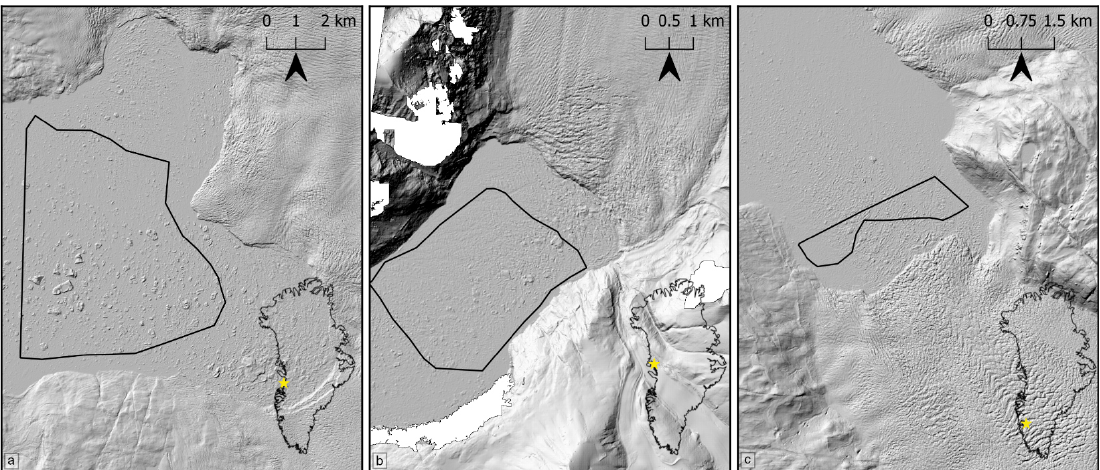
Figure 1. ArcticDEM imagery of the near terminus region for (a) Sermeq Kujalleq: 69.16 ◦ N, 49.91 ◦ W, (b) Umiammakku Isbræ: 71.42 ◦ N, 52.26 ◦ W and (c) Kangiata Nunaata Sermia: 64.25 ◦ N, 49.50 ◦ W. The ROIs for each glacier are mapped by black bounding